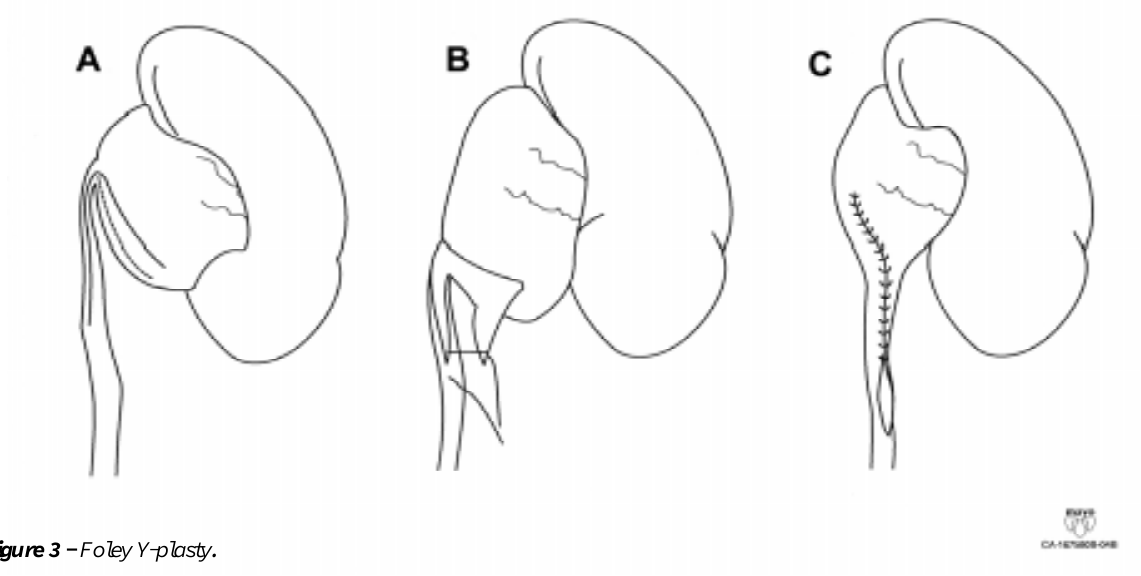
Figure 3 - Foley Y-plasty.